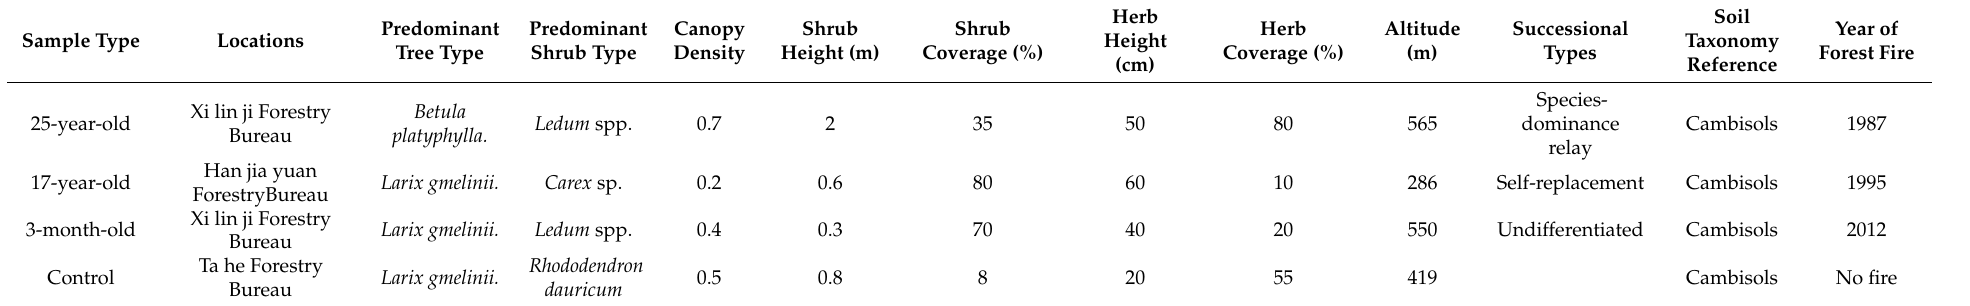
Table 1. General conditions of the studied